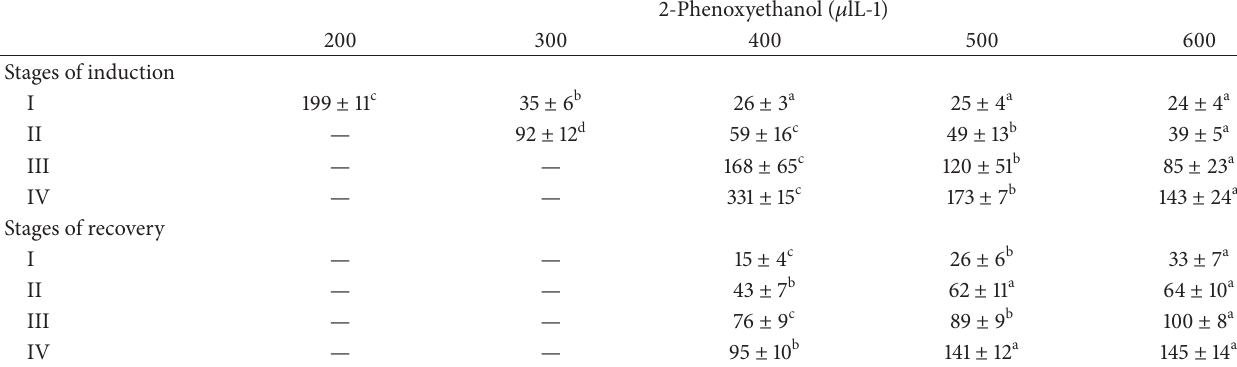
Table 2: Stages of induction and recovery (seconds) exposed to different concentrations of 2-phenoxyethanol (mean ±